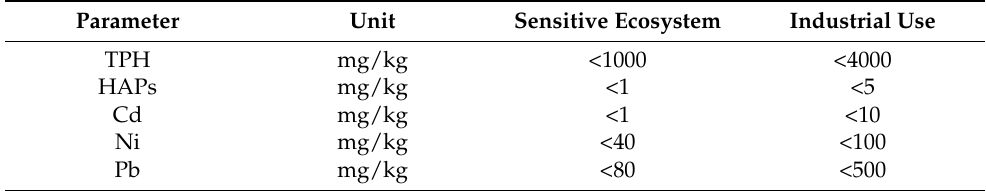
Table 3. Permissible soil limits in the ITT Oil Block of the Ecuadorian Amazon region. Parameter Unit Sensitive Ecosystem Industrial